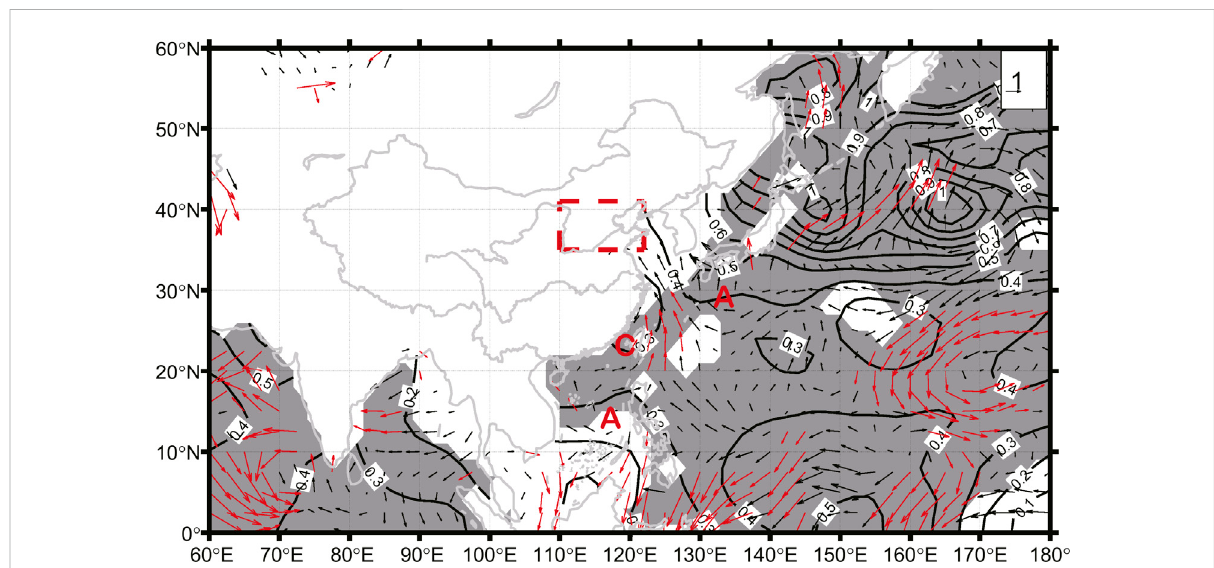
FIGURE 12 ThesameasFigure3butforwindvectorat1,000 hPa(unit:m/s)andSSTinthePaci fi c(unit: ° C).TheisolinesshowthedifferenceinSST.Shaded areas and red arrows indicate a difference reaching 95% con fi dence levels according to Student ’ s t -test. The box shows the region of North China.